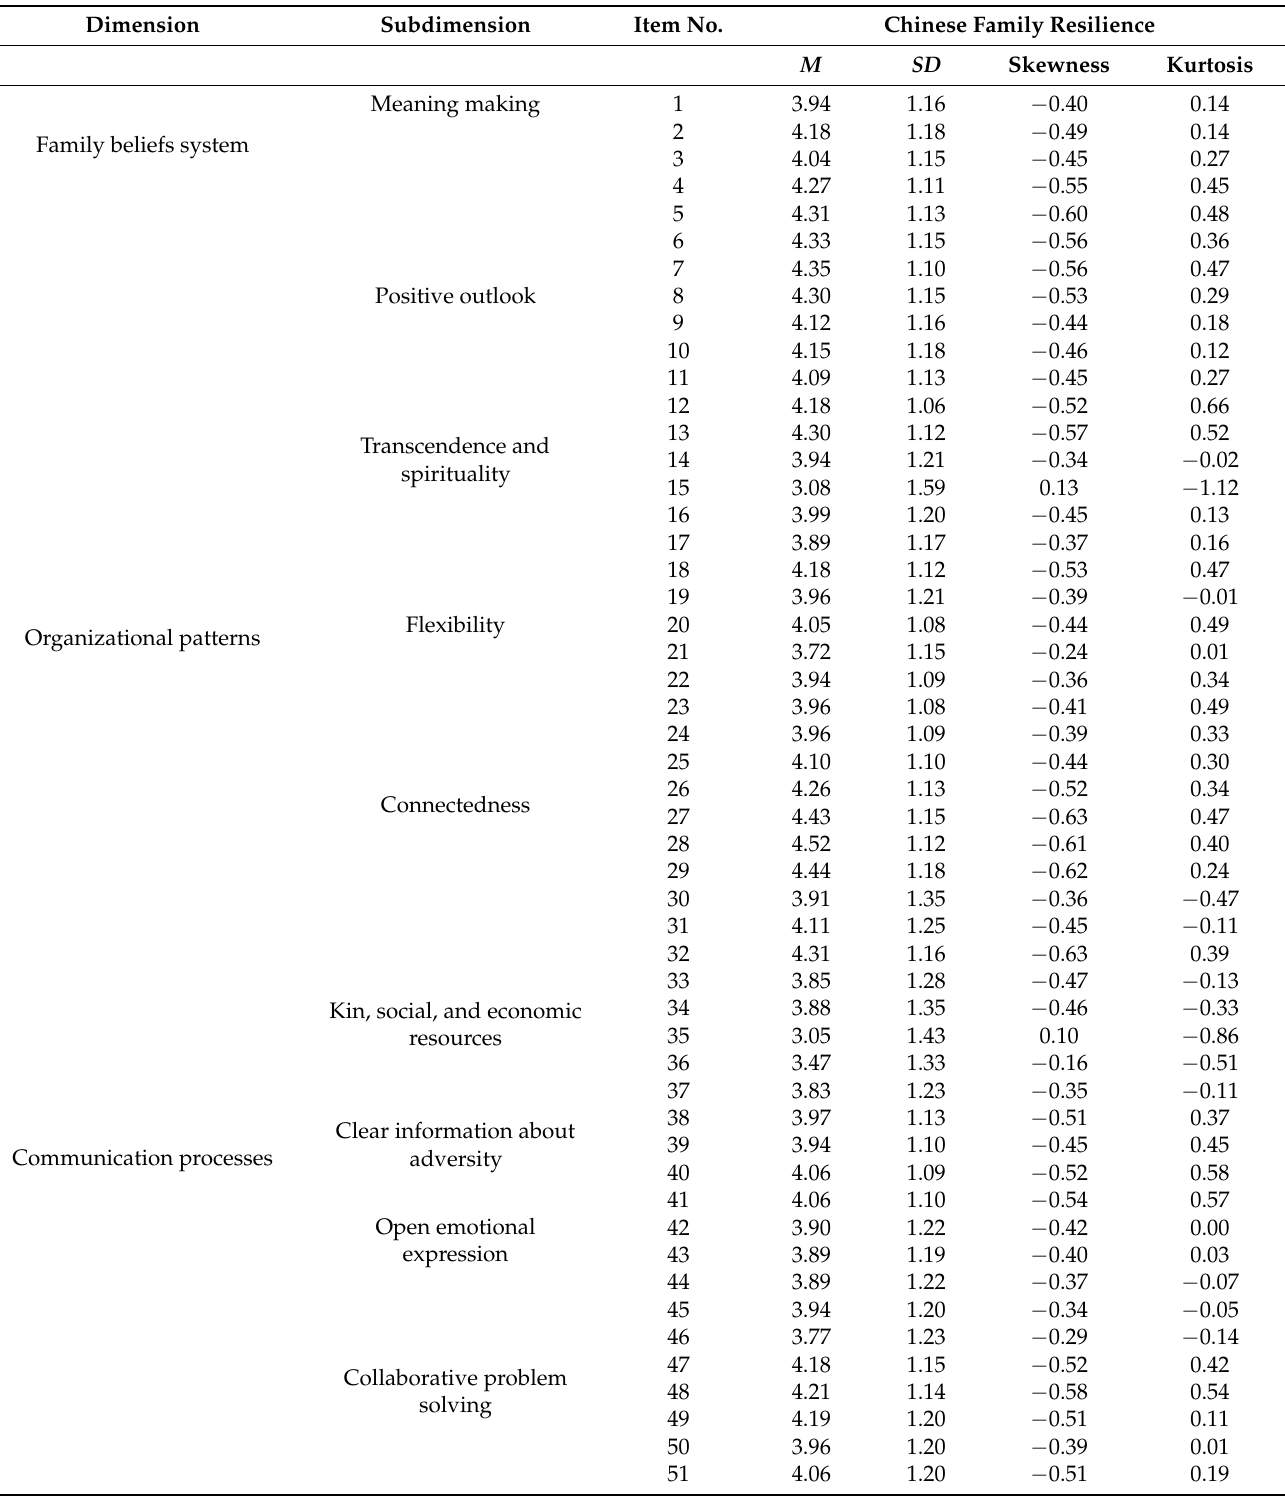
Table 2. Descriptive Statistics of the Chinese Family Resilience Scale